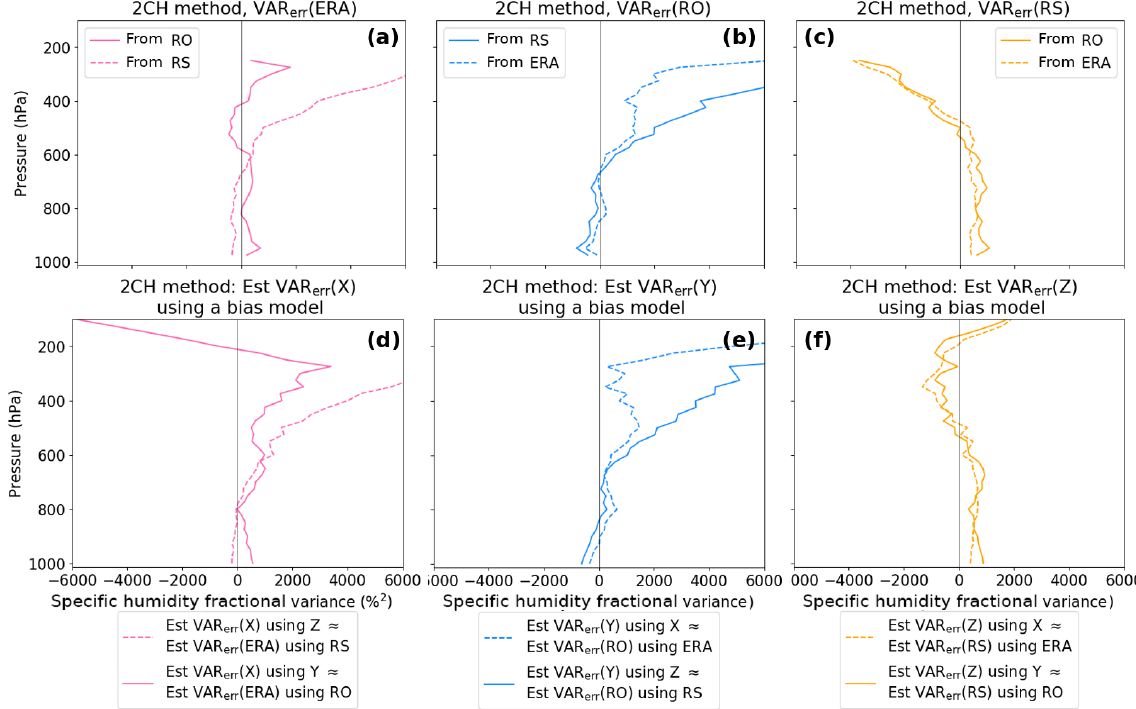
Figure 14. 2CH method error variances for ERA, RO and RS (a–c) and for simulated data using the specified empirical bias profiles (d–f) . Correlation between X and Z errors is zero for this